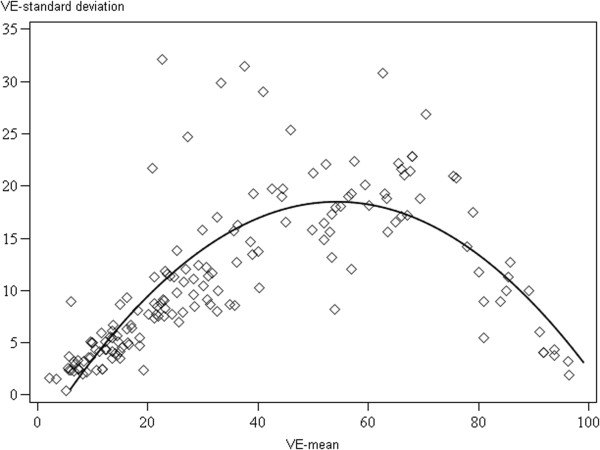
A scatter plot of the means and standard deviations of the five pathologists’ visual estimates (n = 164) with interpolation line.